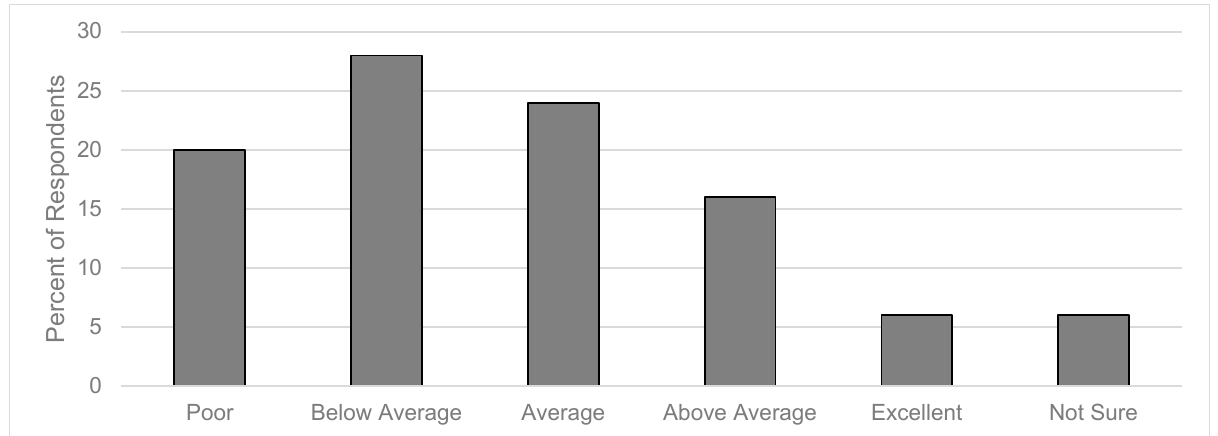
Figure 2. Results of NRCS survey respondents regarding landowner utilization of prescribed fire. Regional sample size: Central n = 14, Northeast n = 5, Southeast n = 12, West n = 19. Chi ‐ square test p ‐ value for a regional effect was p = 0.410 and was non ‐ significant.